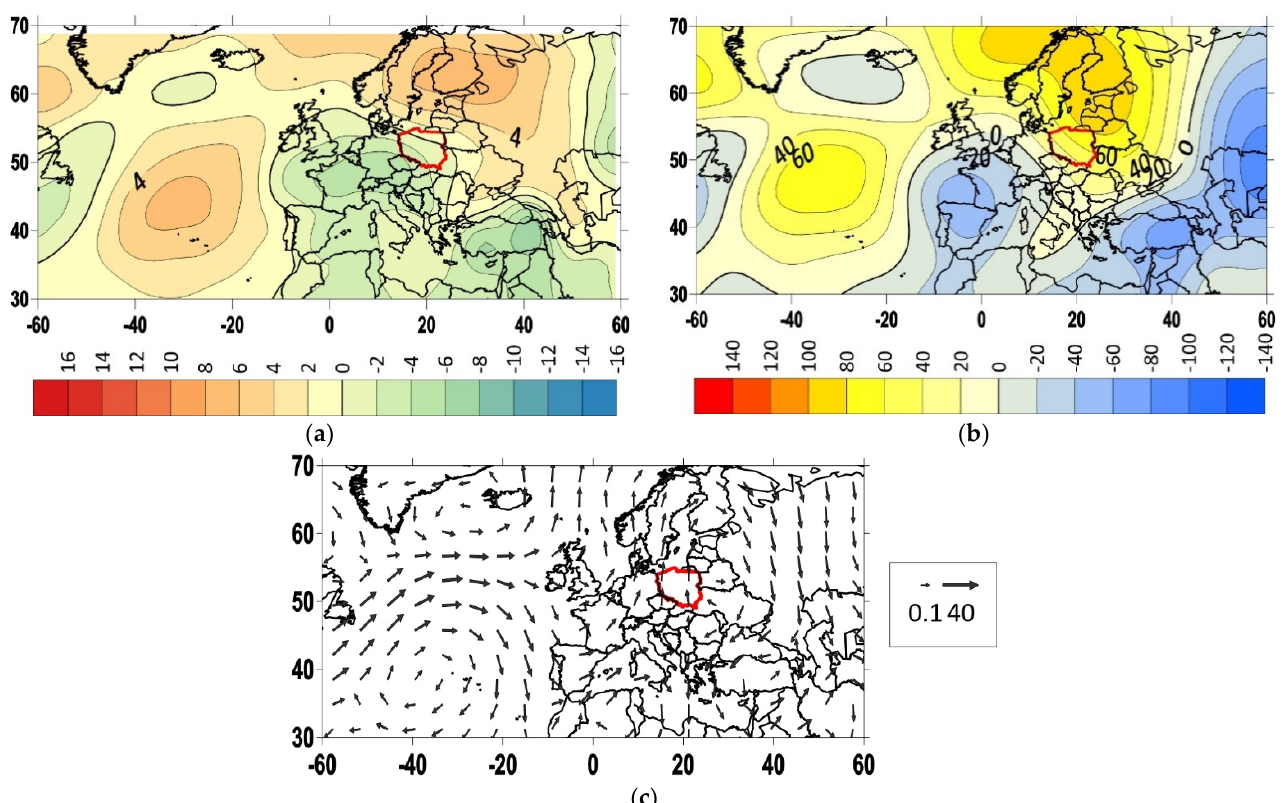
Figure 11. Average fields for the 1963 heat wave: ( a ) anomalies of SLP; ( b ) anomalies of HGT700 mb; ( c ) wind at 700 hPa level. The red line marks the borders of Poland.